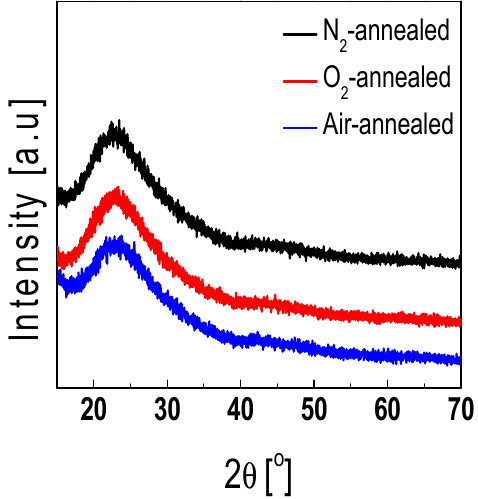
Figure 5. X-ray diffraction (XRD) patterns of N 2 -, O 2 -, and air annealed 20 nm-thick IGTO thin films deposited on the glass substrates.